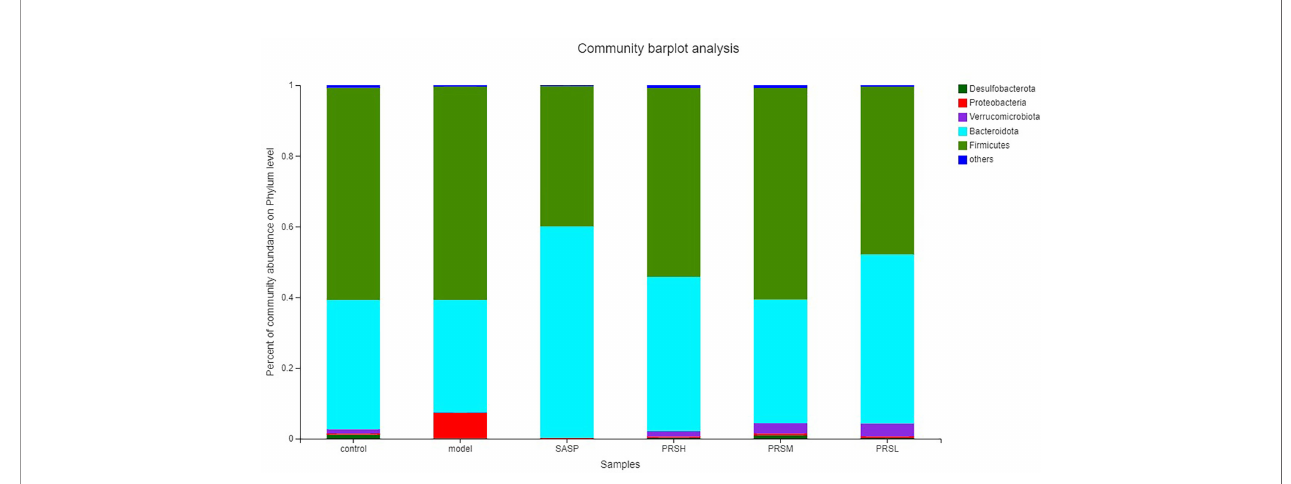
FIGURE 11 | Community barplot analysis on phylum level.